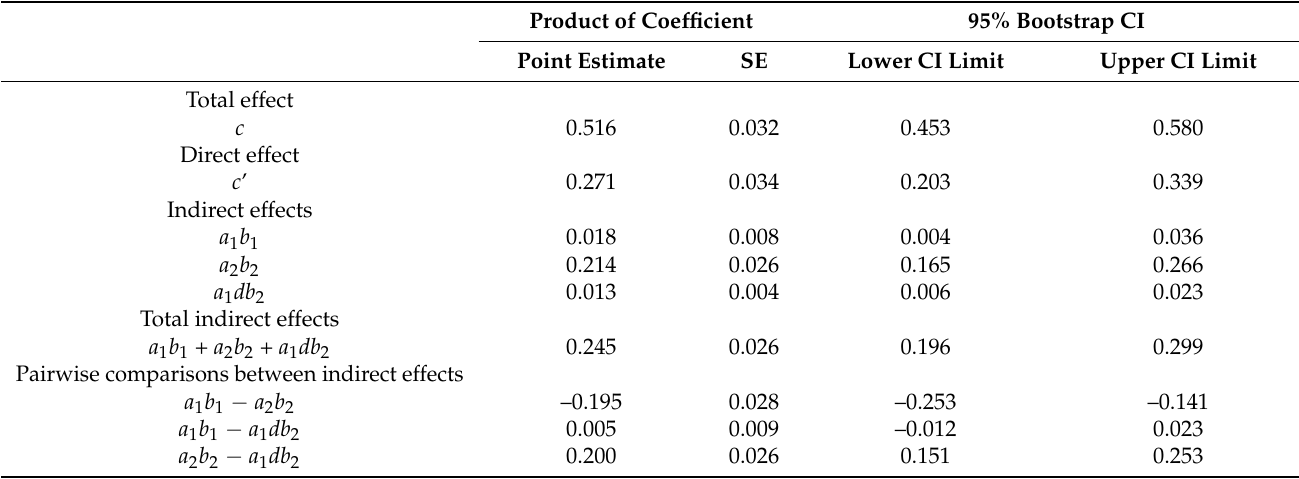
Table 4. Total direct, direct, total indirect, and indirect effects, and pairwise comparisons between indirect effects with 95% bootstrap confidence intervals while controlling for diabetes